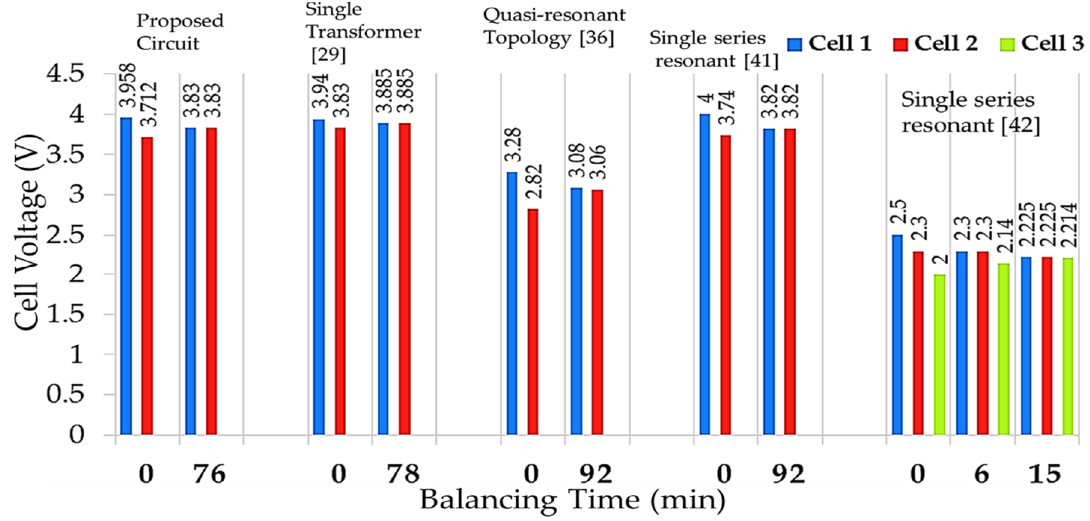
Figure 13. Balancing circuit result comparison: proposed circuit to other works.